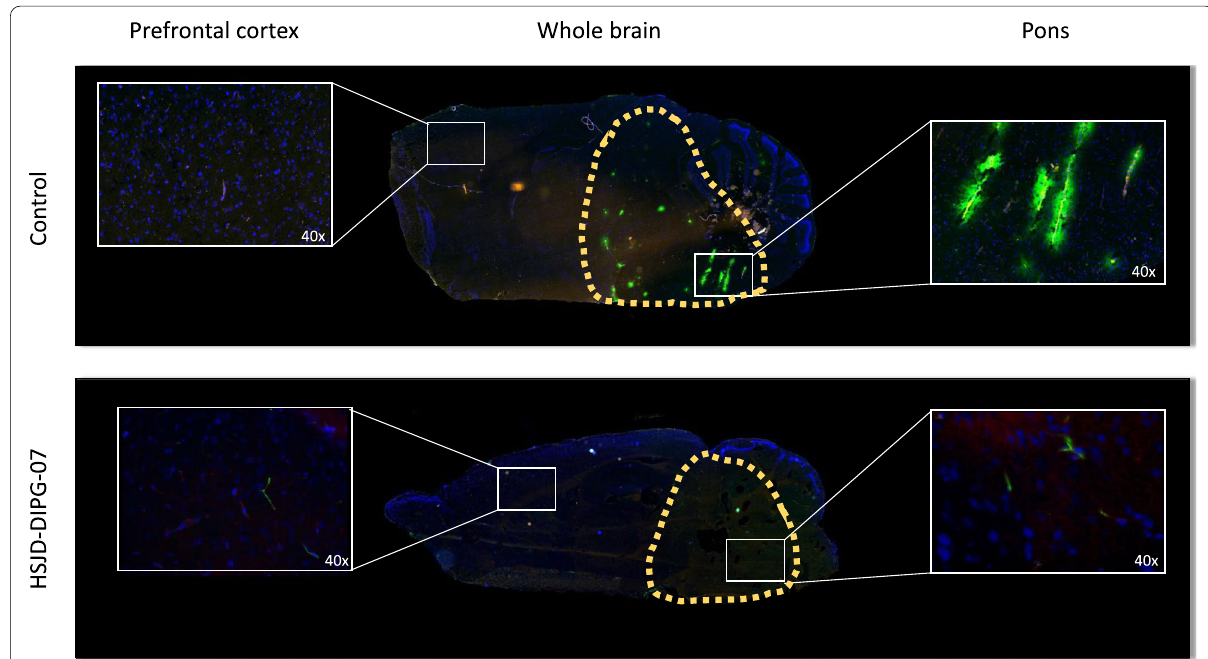
Fig. 5 Immunofluorescent PEG staining on sagittal slices of FUS-treated mouse brains. A positive staining of liposomes (in green) was detected in the pontine region of control (non-tumor bearing mice) (upper panel) who received Caelyx ® . The pontine/tumor area delineated with a yellow dotted line. In contrast, only few liposomes were observed in the blood vessels of the HSJD-DIPG-07 xenograft model that received Caelyx ® (lower panel). In both panels endothelial cells are indicated in red (CD31 staining), nuclei in blue